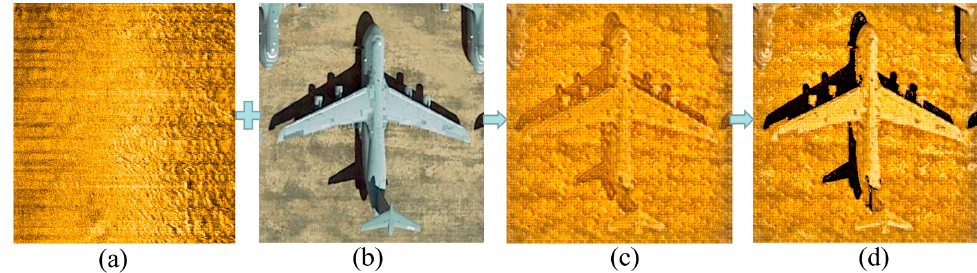
Figure 6. Original sonar image with optical target transfer to sonar style target. ( a ) Original sonar image. ( b ) Optical image. ( c ) Traditional style transfer image. ( d ) Feature enhancement style transfer